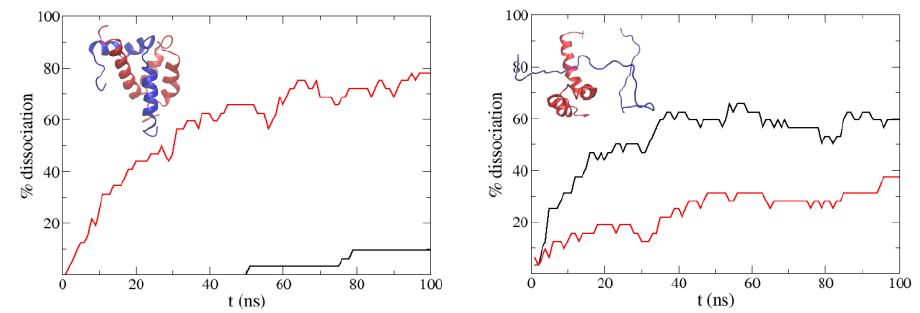
Figure 8. Percentage of dissociated molecules along the simulations starting from the experimental ACTR:NCBD complex ( left ) and from a non-native bound structure ( right ) using the normal PAC- SAB force field (black line) and when hydrogen bonding is removed (red line). The experimental ACTR:NCBD complex is shown in the left panel (ACTR is the blue